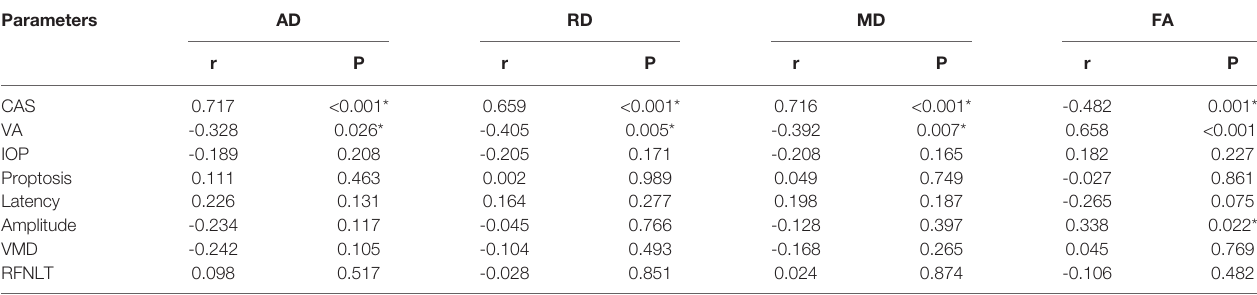
TABLE 4 | Correlations of DTI Parameters and Ophthalmological Characteristics. Parameters